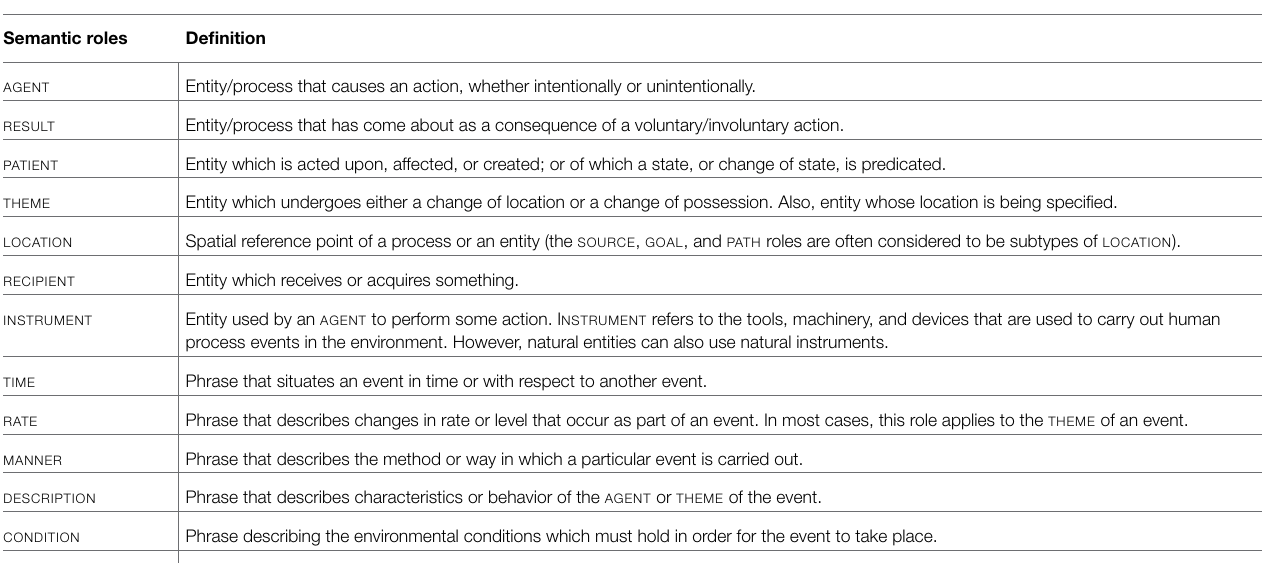
TABLE 2 | List of semantic roles and their definitions, based on Kroeger (2005, p. 54–55) and Thompson et al. (2009). Semantic